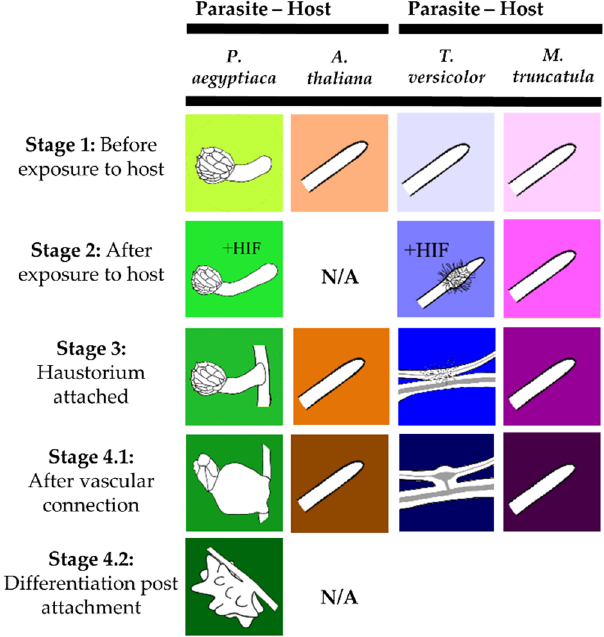
Figure 1. Stages of the Orobanchaceae species analyzed for metabolite profiles in this study. These stages correspond to those studied in previous transcriptome studies of Orobanchaceae [20,21]. Corresponding host roots of A. thaliana and M. truncatula were collected for each stage indicated for the parasites P. aegyptiaca and T. versicolor , respectively. Figure was adapted from Yang, Wafula, Honaas, Zhang, Das, Fernandez-Aparicio, Huang, Bandaranayake, Wu, Der, Clarke, Ralph, Landherr, Altman, Timko, Yoder, Westwood, and dePamphilis [21].